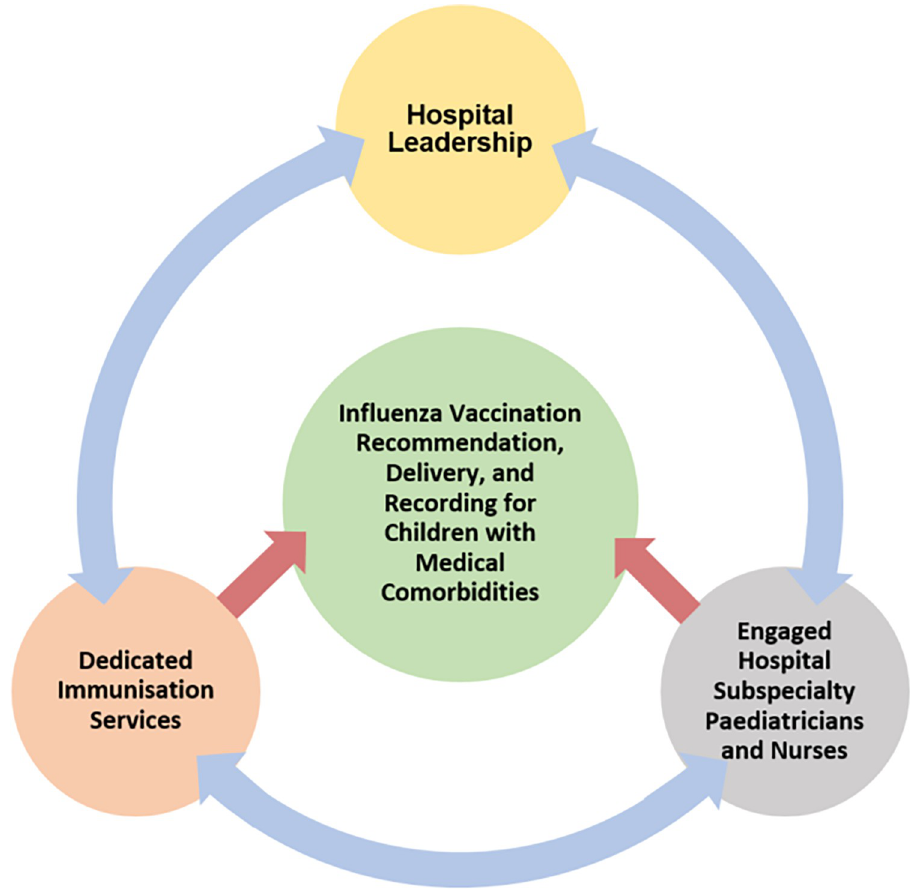
Fig 1. The elements that directly and indirectly influence and drive influenza vaccination, recommendation delivery for children with comorbidities in Australian